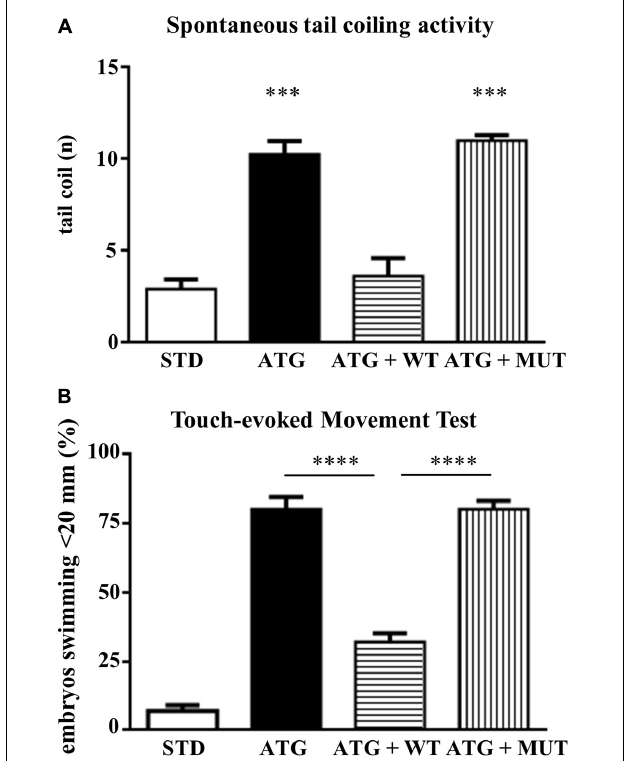
FIGURE 7 | Analysis of locomotor behavior. (A) The graph shows the number of spontaneous flipping movements during 1 min observation in embryos at 24 hpf, injected with STD or ATG morpholino, together with either WT or MUT human C19orf12 mRNA. (B) The graph resumes the main results from the analysis of the swimming performance of embryos of the same categories as in (A) , at 48 hpf in the touch-evoked test. Bars represent the percentage of embryos covering a distance lower than 20 mm. **** P < 0.0001 (One way ANOVA, corrected with Tukey’s multiple comparisons